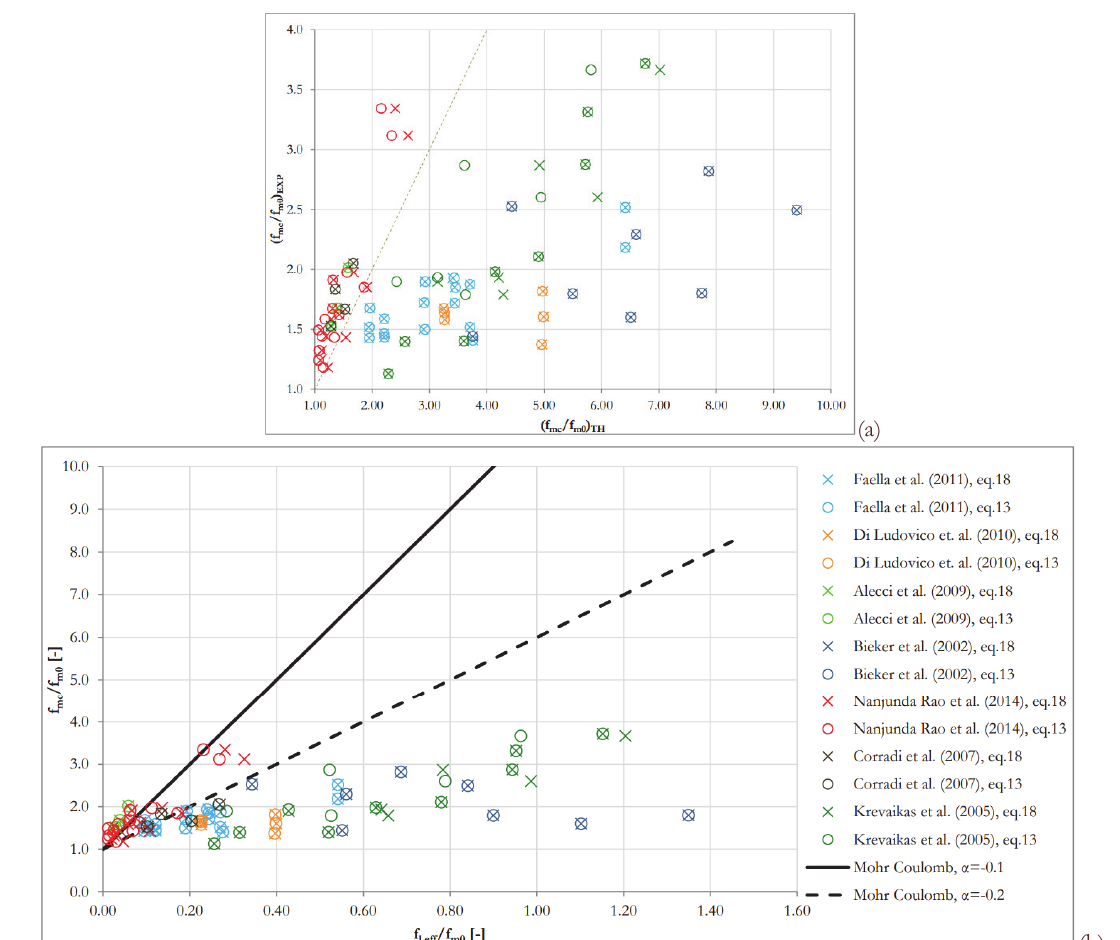
Figure 8: Comparison between experimental results and Mohr-Coulomb models: a) experimental and theoretical results comparison, b) confinement curve comparison for α =-0.1 (black solid line) and α =-0.2 (black dashed line).